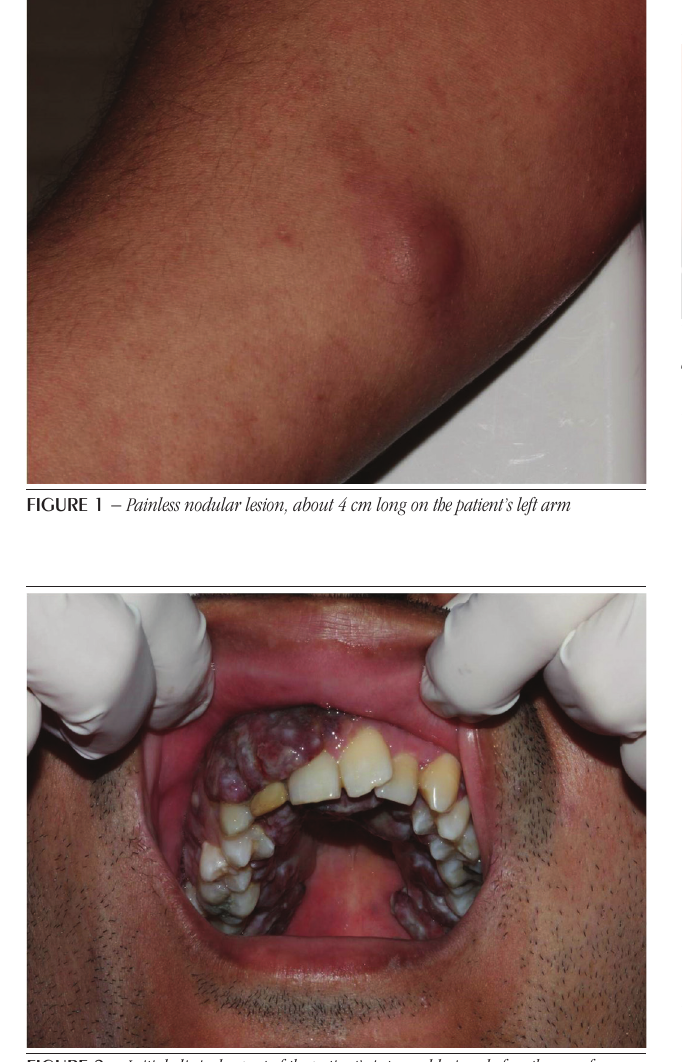
figurE 3 − Proliferation of endothelial and pleomorphic mesenchymal cells. Formation of irregular blood vessels in the shape of cracks